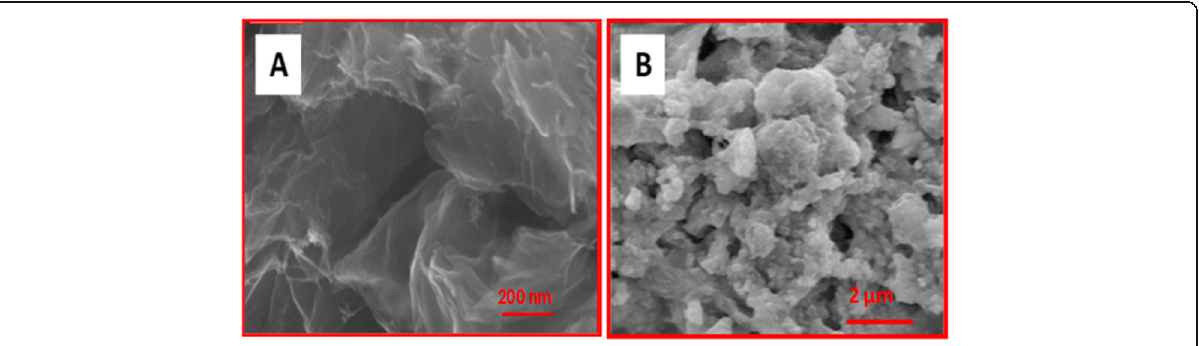
Fig. 6 SEM images of a GO and b MGO- β -CD